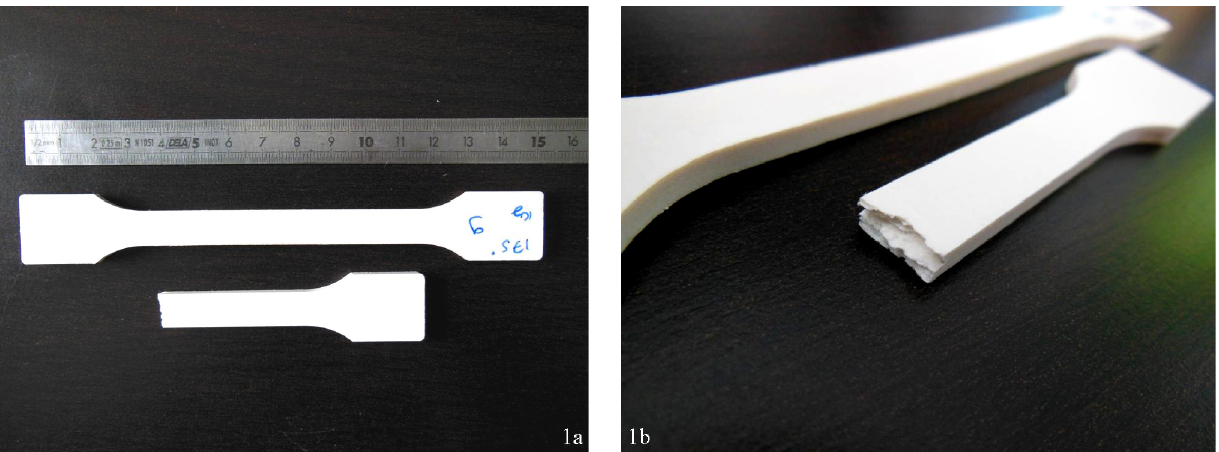
Figure 1. (a) α -cellulose compression-molded specimen; (b) Bending fracture where the laminated structure can be